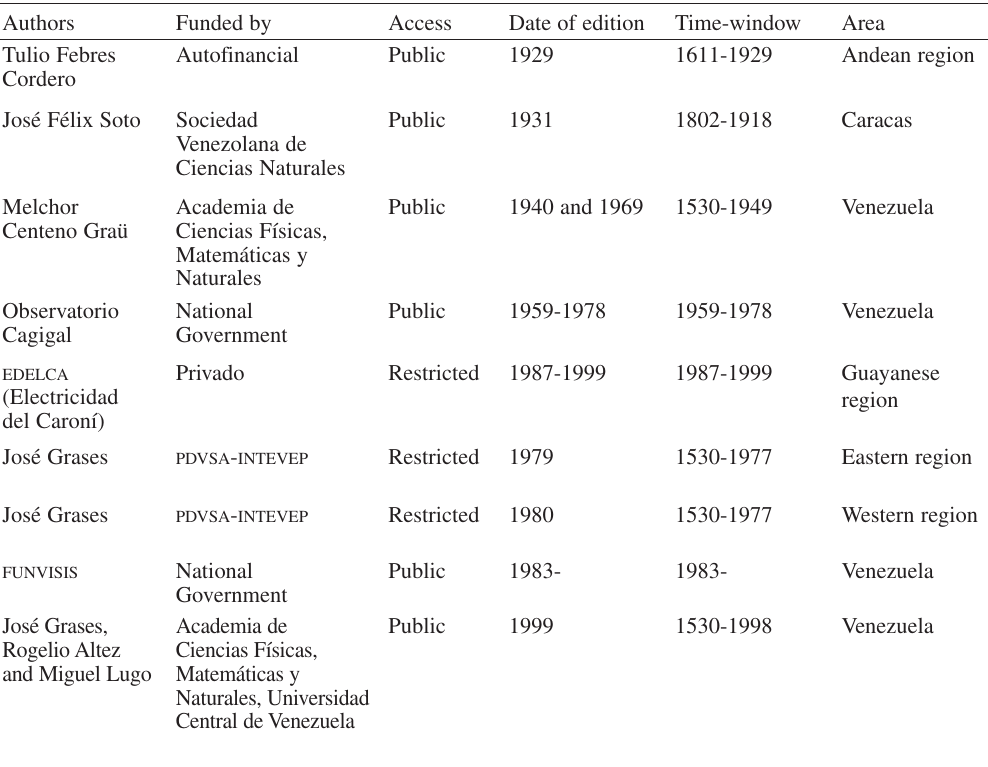
Table I. Descriptive and Parametric Catalogues in